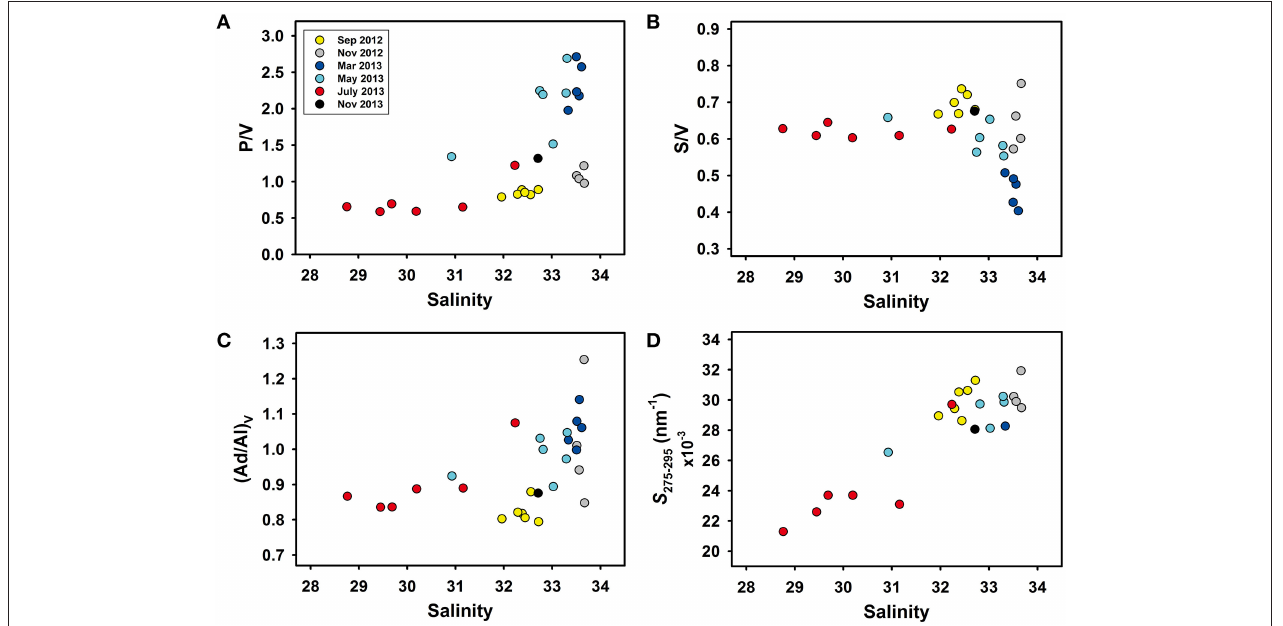
FIGURE 3 | Relationships between salinity and lignin phenol compositions (A) molar ratio of p -hydroxy phenols to vanillyl phenols (P/V), (B) molar ratio of syringyl phenols to vanillyl phenols (S/V), (C) molar ratio of vanillic acid to vanillin phenols [(Ad/Al) V ], and (D) the spectral slope coefficient of CDOM absorption coefficient spectrum between 275 and 295nm ( S 275 – 295 ) in surface waters of Otsuchi